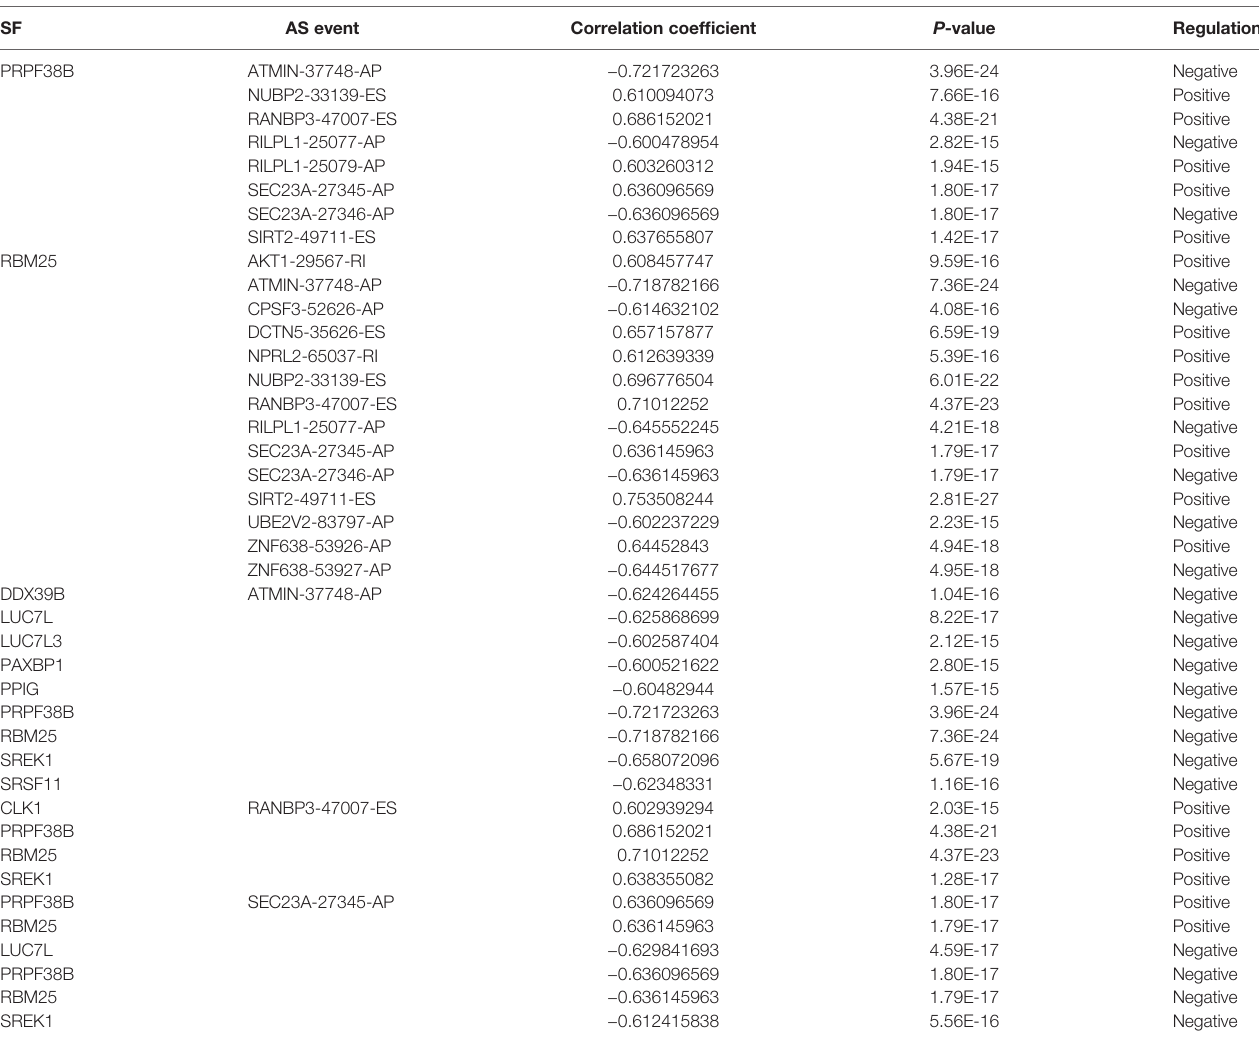
TABLE 3 | The correlation of hub SF genes and AS